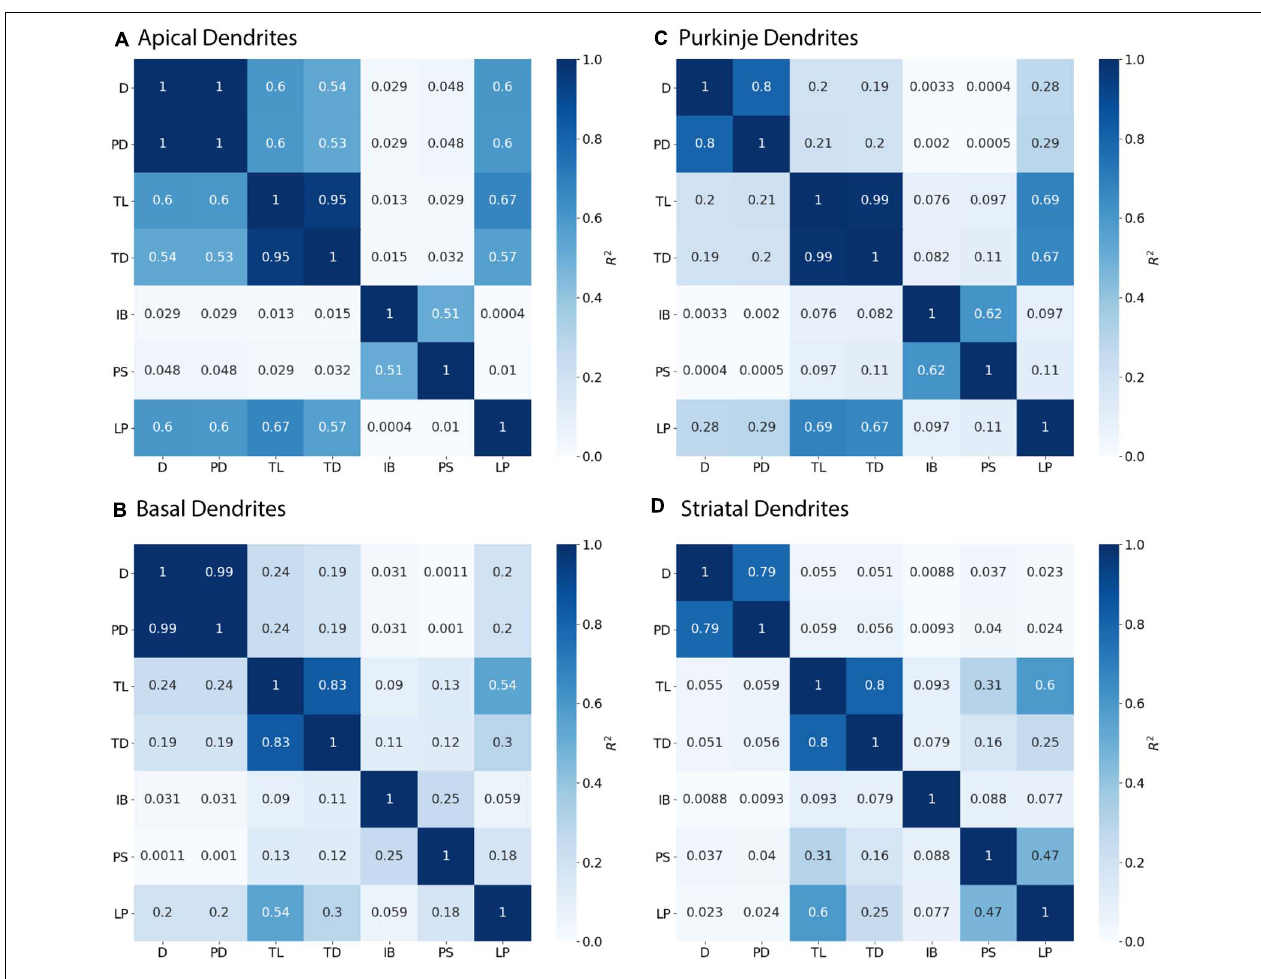
FIGURE 4 | Parent Diameter predicts diameter for continuing nodes. R 2 as Pearson’s coefficient of determination. TL, Total Dendritic Length Rooted at Node; TD, Terminal Degree; IB, Initial Branch Order; PD, Parent Diameter; PS, Path from Soma; LP, Longest Path to Terminal End; and D, Diameter. Morphology feature descriptions from Table 2 . (A–D) Diameter of continuing nodes have strong correlation with PD across morphologies. Apical dendrites of hippocampal pyramidal cells have multiple features with moderate to strong correlation with diameter. Remaining cell types have low correlation with other features.